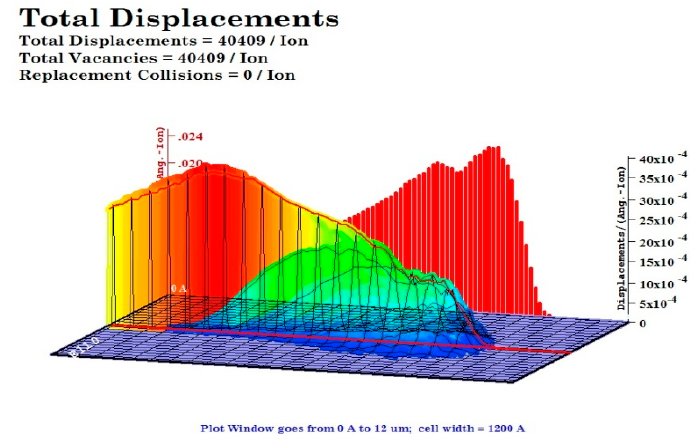
Figure 16. Damage caused by 90 MeV Iodine in E110 alloy.